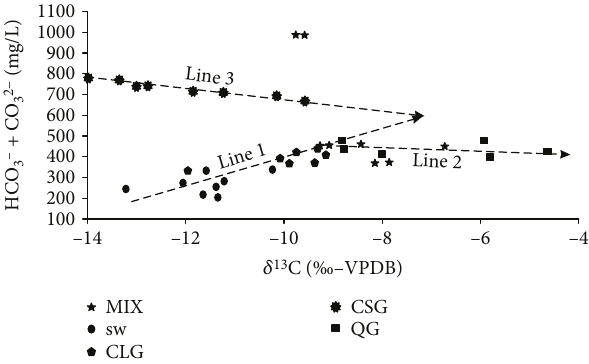
− diagram of the water Figure 6: δ 13 C versus CO 32 − +HCO 3 samples. MIX: mixing water; CLG: Cambrian aquifer groundwater; QG: Quaternary aquifer groundwater; sw: surface water; CSG: coal-bearing sandstone aquifer